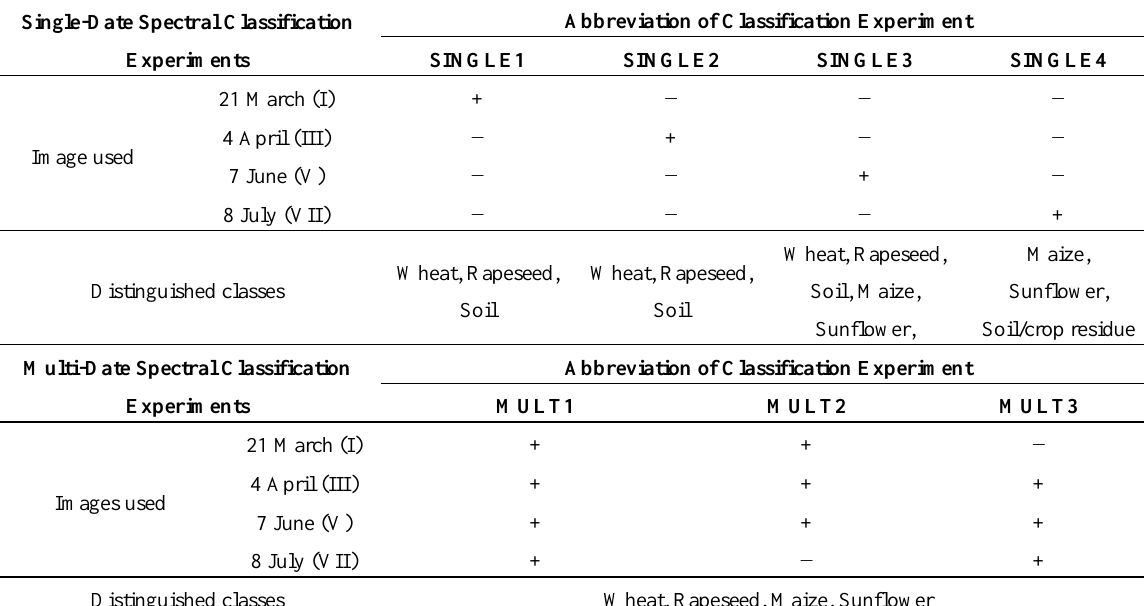
Table 4. Overview of the classification experiments conducted using either (i) single-date spectral data or (ii) multi-date spectral data. The roman numbers identify the individual PROBA-V images used for the classification (see Table 3). The classified crops and cover types are also